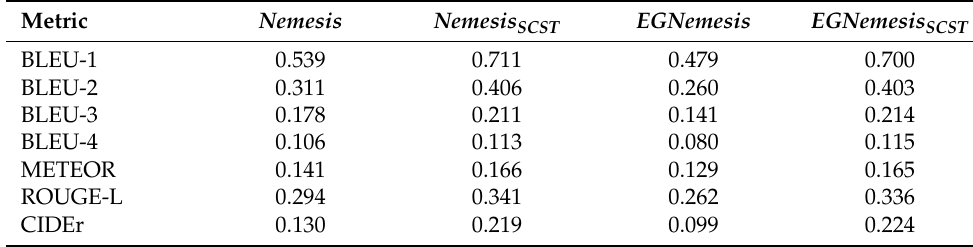
Table 4. The comparison of the results before and after applying the SCST fine-tuning.